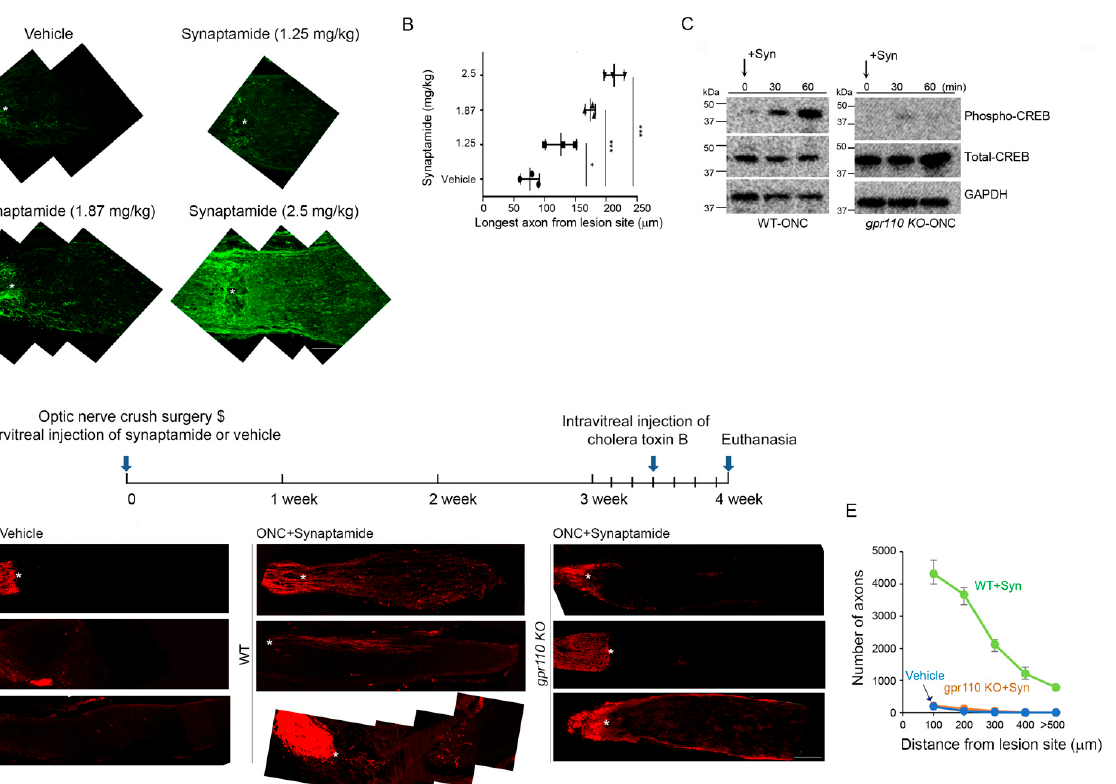
To improve the stability of the endogenous ligand synaptamide, we generated (4Z,7Z,10Z,13Z,16Z,19Z)-N-(2-hydroxy-2-methylpropyl)docosa-4,7,10,13,16,19-hexa- enamide (A8, NCGC00248435), a methylated analogue that is resistant to hydrolysis by fatty acid amide hydrolase (FAAH) (Figure 6A,B). This analogue exhibited GPR110-de- pendent improvement of efficacy and potency in cAMP production compared to synap- tamide (Figure 6C). The 3D-model of the GPR110 GAIN domain previously established for synaptamide binding [11] revealed that the two methyl groups of A8 introduced to the synaptamide structure fit well in the hydrophobic packet created by two proline residues, P417 and P476 (Figure 6D). This hydrophobic interaction can stabilize the existing hydro- gen bonding between the polar moieties in GPR110 and synaptamide, increasing binding